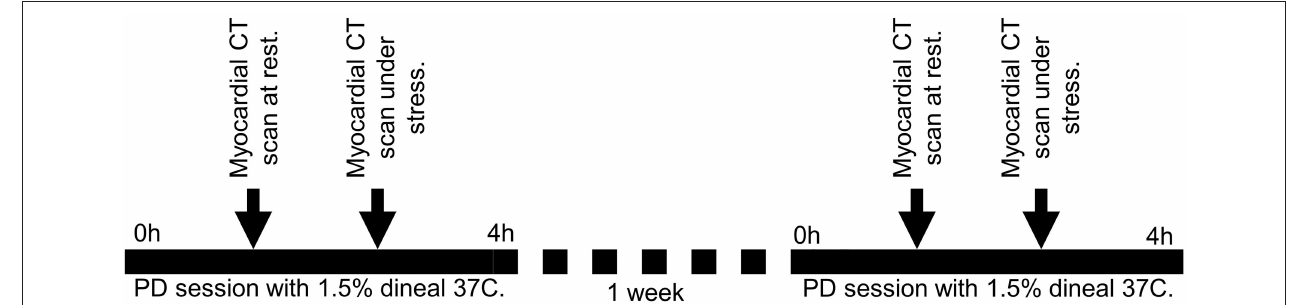
FIGURE 1 | Design of the study. Patients underwent cardiac CT scans after a normothermic dialysis (NT) – 37 ◦ C (visit 1) and 1 week later, they underwent repeat CT scans after a cooled 4h PD (TH) – 32 ◦ C (visit 2). At each visit, patient hearts were CT scanned twice for myocardial perfusion. The first scan was performed at rest; the second scan was performed 10min after intravenous administration of adenosine to provide pharmacological